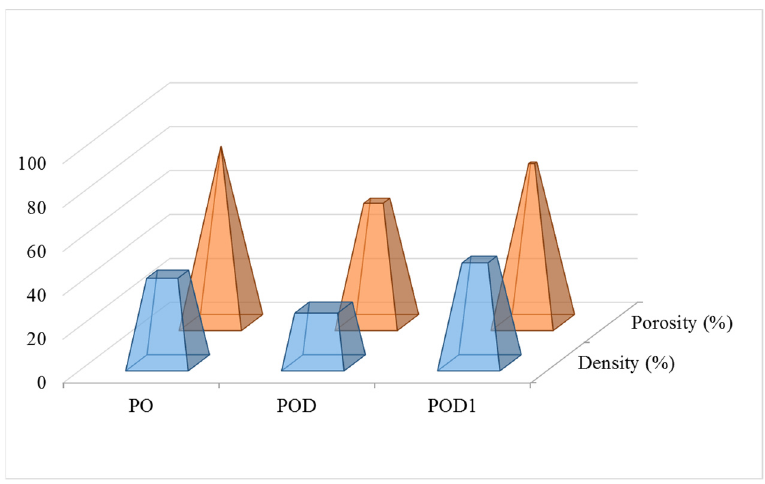
Figure 5. Density and porosity levels recorded for the pullulan–dopamine cryogels.